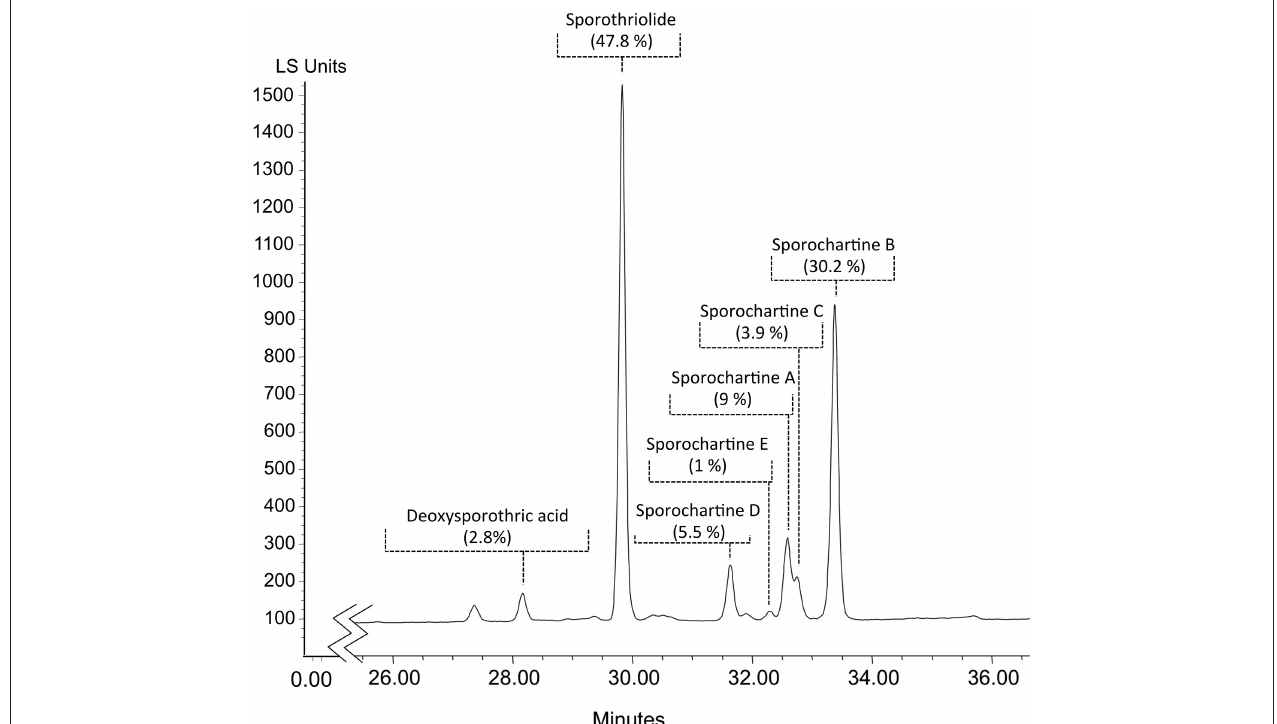
FIGURE 2 | HPLC analysis of the ethyl acetate extract of Hypoxylon monticulosum CLL-205 cultivated in PBD for 9 days. Percentages were deduced from peak integration based on Light Scattering Detection chromatogram (LSD).